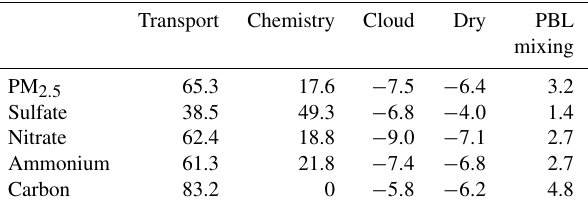
Table 1. Relative contributions of each of the five processes (trans- port, chemistry, cloud, dry, and PBL mixing) to SWHD formation in BTH (unit: %). The process analyses are carried out for both PM 2 . 5 and its components, following Eq. (1) described in Sect. 5.